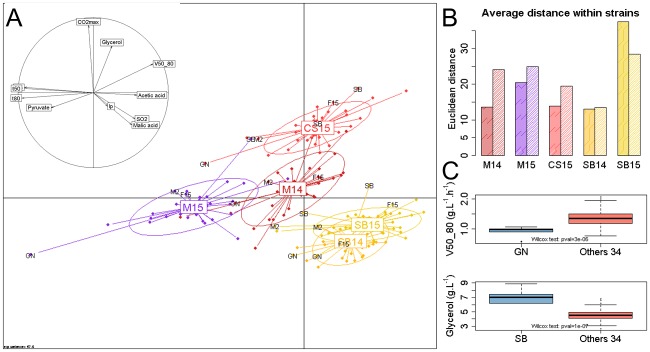
PCA of winemaking properties of 35 strains in five grape juices.Panel A. The first two axes of the PCA performed from the average of two replicates for 11 phenotypes measured in the five grape juices and 35 strains. Axes 1 and 2 explain 41.8% and 15.8% of total variation, respectively. Each point represents the fermentation of one strain and is colored according to the grape juice used. Points are connected to their group gravity centers that are labeled with the grape juice name M14, M15, SB14, SB15, CS14. Ellipses diameter corresponds to the standard deviations of the projection coordinates on the axes. The correlation circle indicates the correlation of the variables for axes 1 and 2. Panel B. Euclidian distances within all the strains for each grape must. The bar plot represents the Euclidian distances within the 35 strains according to kinetics (high density colored bar) and metabolic parameters (low density colored bar) for each grape juice. Panel C. Comparison of the trait value of GN and SB respect to the 34 others strains for V50_80 and the glycerol produced, respectively. A boxplot was generated from the ten phenotypic values measured in the five grape juices with two replicates for GN and SB, and from the 340 values of the 34 other strains. Significant differences were estimated by applying the Wilcoxon-Mann-Withney test (α = 0.05).